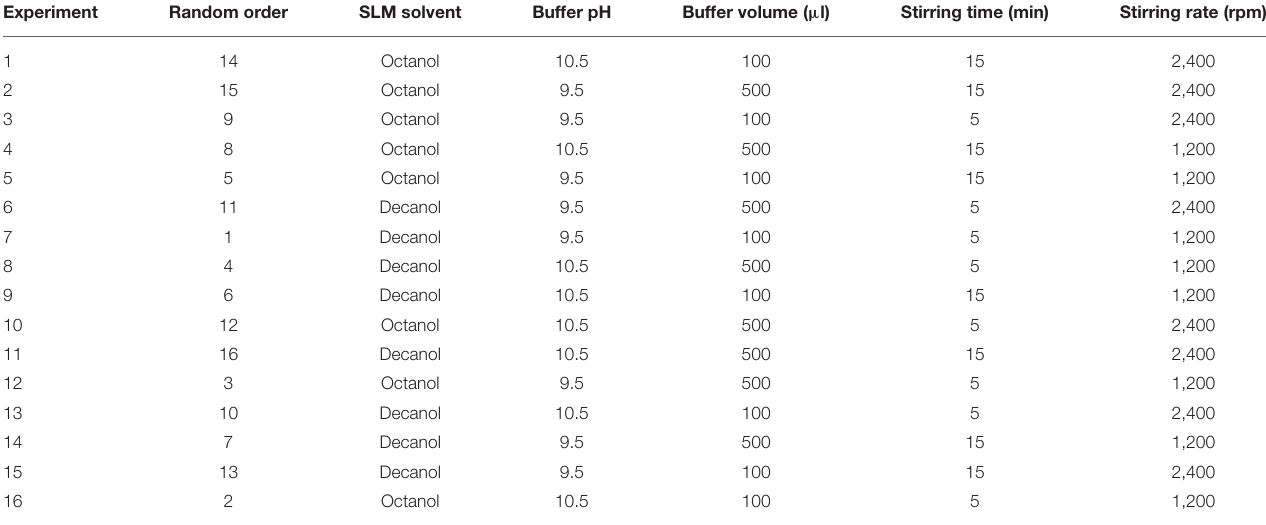
TABLE 2 | Experimental matrix for the fractional factorial design. Experiment